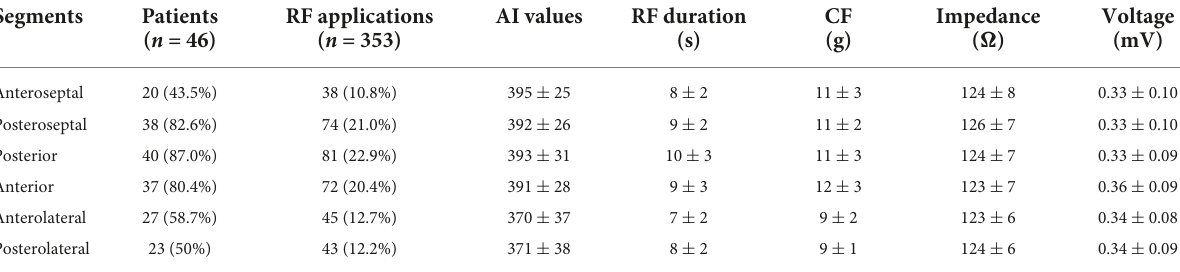
TABLE 2 Characteristics of the SVC ablation lesions in different